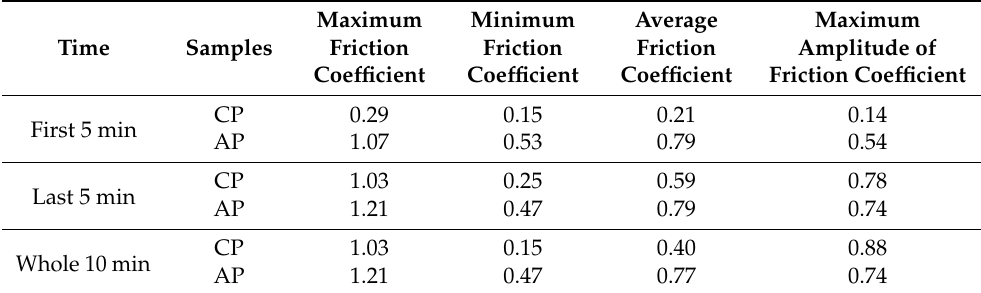
Table 5. Data of friction